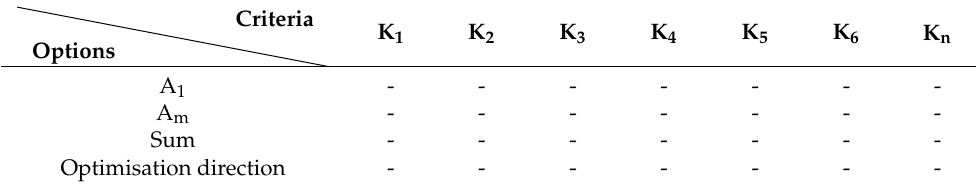
Table 5. The initial Matrix P of alternative solutions.